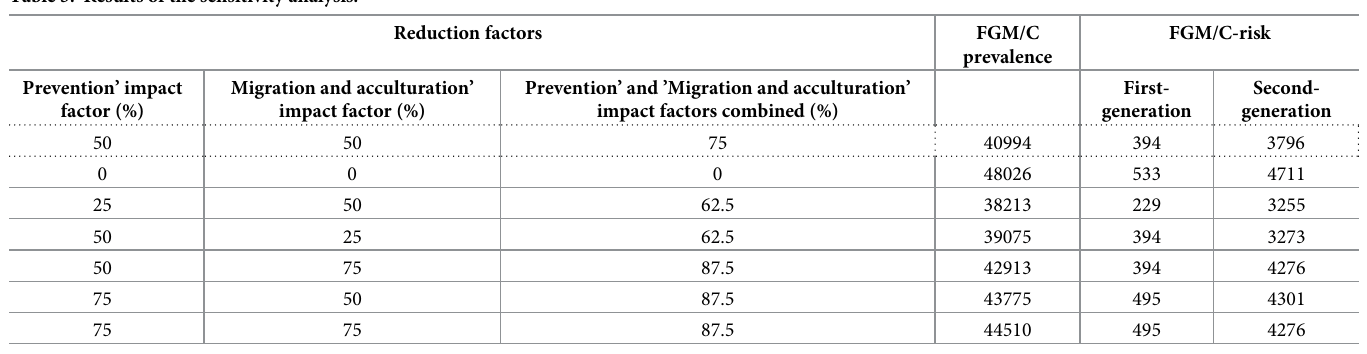
Table 3. Results of the sensitivity